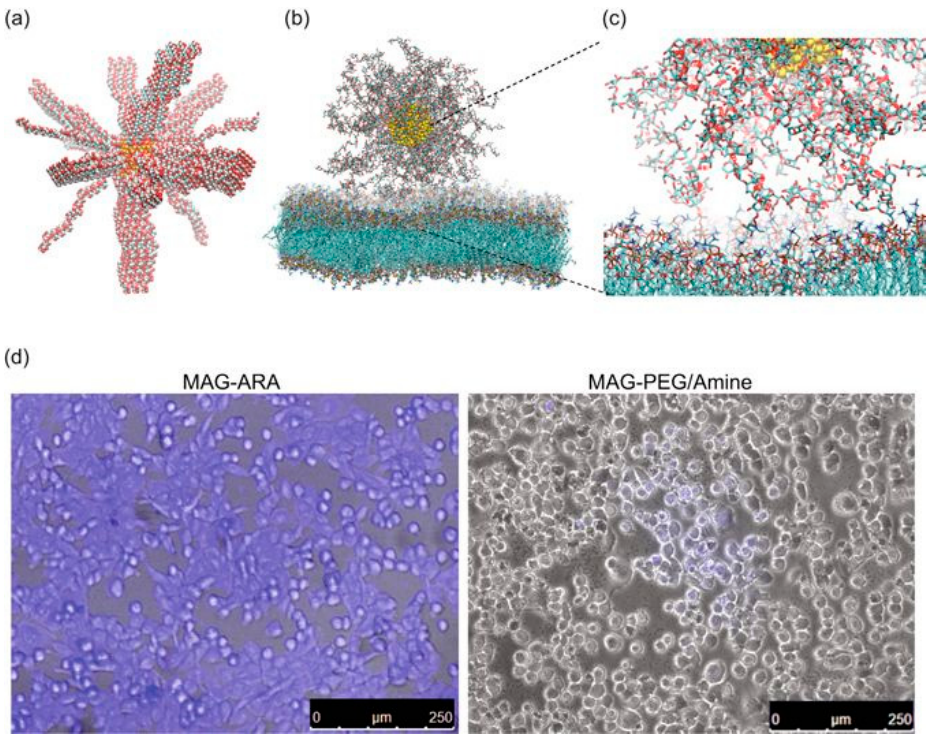
Figure 6. Membrane interaction and internalization of the polyarabic ‐ coated magnetite nanoparticle, MAG ‐ ARA. ( a ) Initial configuration of MAR ‐ ARA in vacuum. ( b ) Final configuration of MAR ‐ ARA in contact with a dipalmitoyl phosphatidylcholine (DPPC) bilayer. ( c ) Example of the interactions of L ‐ arabinose and D ‐ galactose with DPPC. ( d ) Confocal fluorescence image and a bright filed image from human breast cancer cells incubated with MAG ‐ ARA, left, and control nanoparticles, right. Reprinted from [44] under a CC BY 4.0 license. Copyright Patitsa, M., Karathanou, K., Kanaki, Z.,